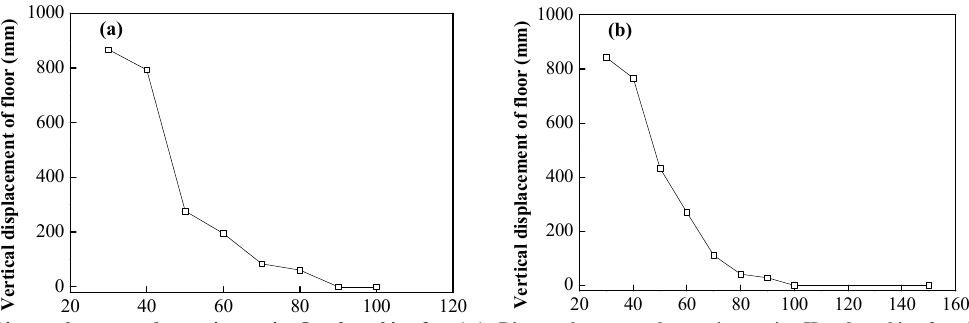
Figure 14. The relation curve between the vertical displacement of the floor and the distance from the working face to the measuring station. ( a ) Relation curve of floor displacement and the distance between the I# station and working face; ( b ) relation curve of floor displacement and the distance between the II# station and working face.